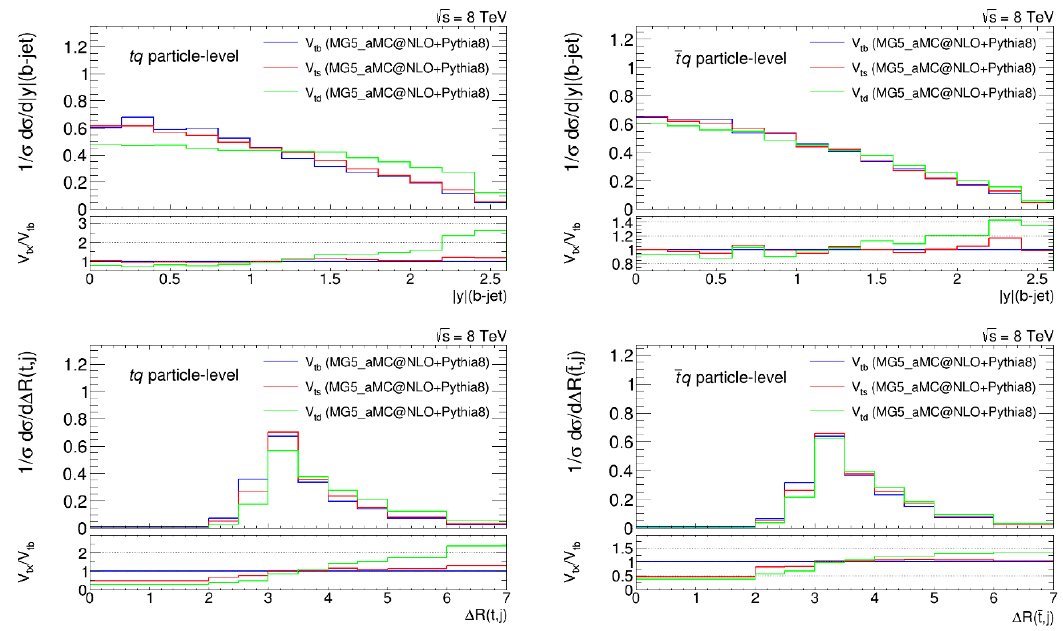
Figure 5 . Comparison of the normalized di(cid:11)erential cross sections for single top (left) and anti-top (right) quark cross sections via Wtb (blue line), Wts (red line) and Wtd (green line) interactions at particle level as a function of the b -jet j y j ((cid:12)rst row) and (cid:1)R (top, jet) (second